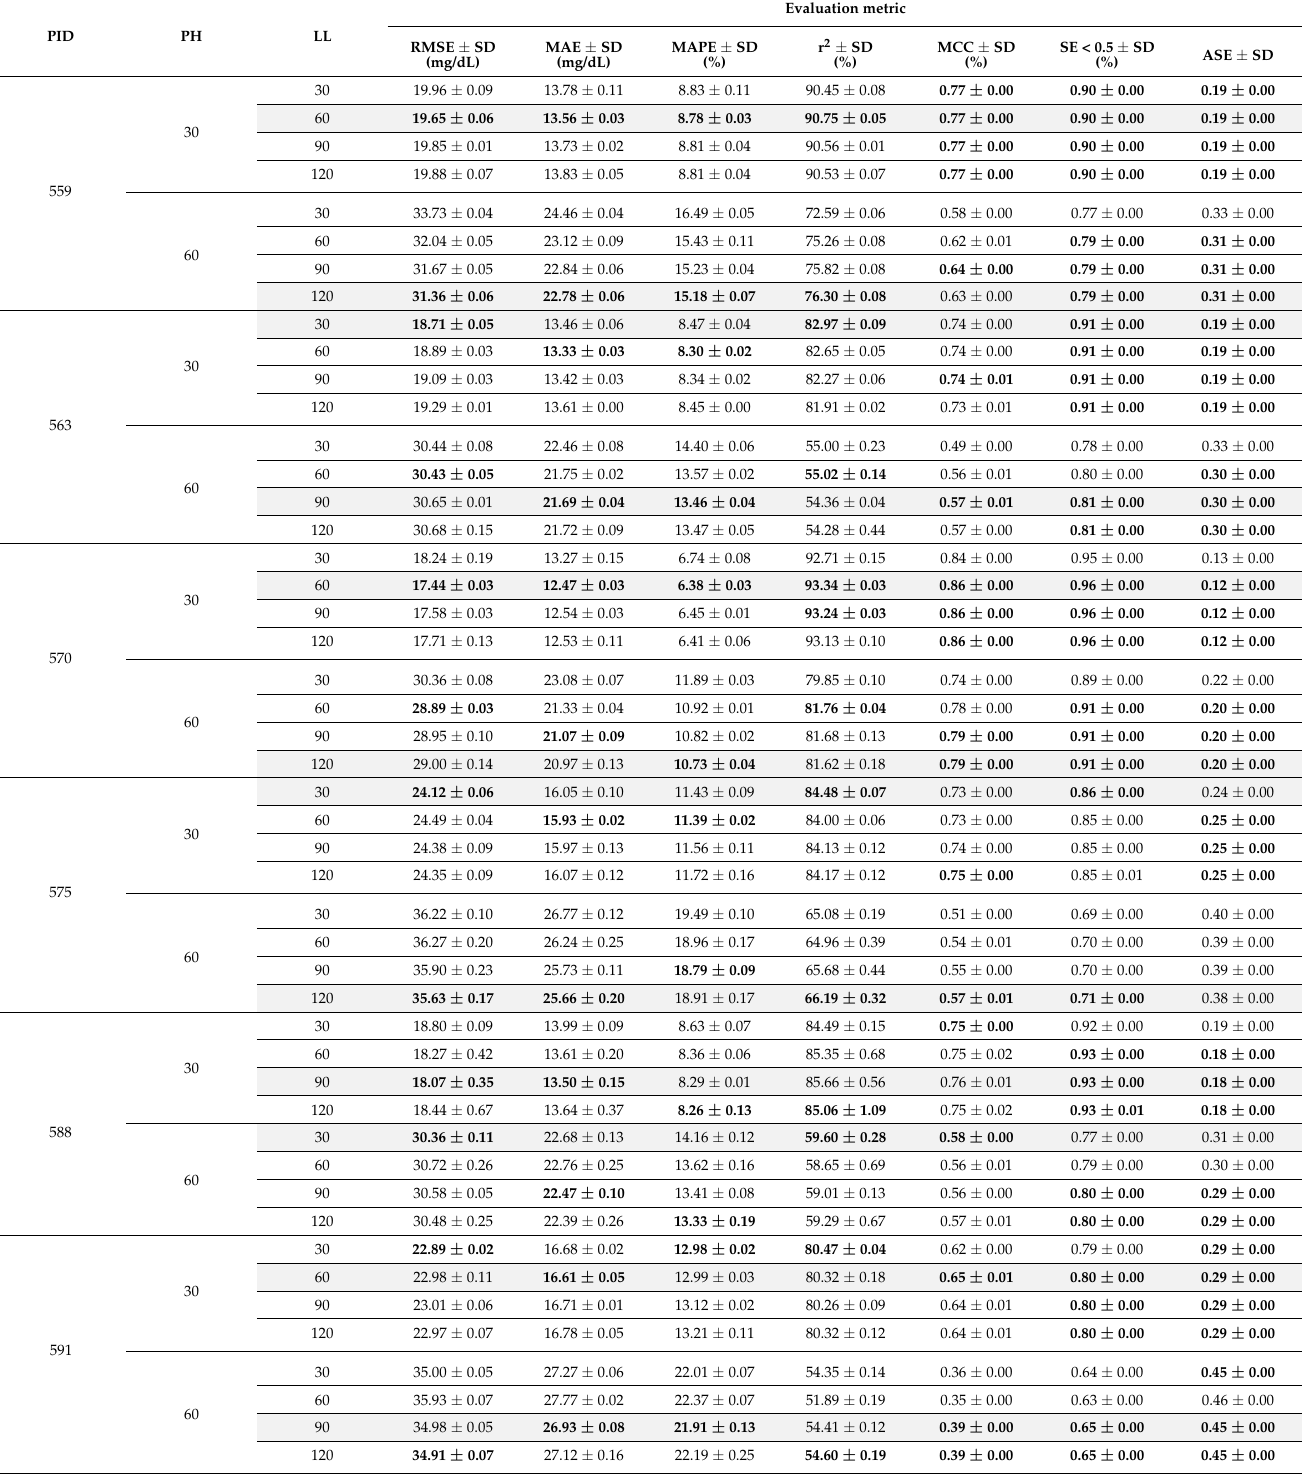
Note. Values in bold indicate the best evaluation outcome for each metric in each learning scenario, and grey highlights denote the best model in each scenario based on the best-achieved evaluation metrics. Note. PID: patient identification; PH: prediction horizon; LL: lag length; RMSE: root mean square error; SD: standard deviation; MAE: mean absolute error; MAPE: mean absolute percentage error; r 2 : coefficient of determination; MCC: Matthew’s correlation coefficient; SE: surveillance error; ASE: average surveillance